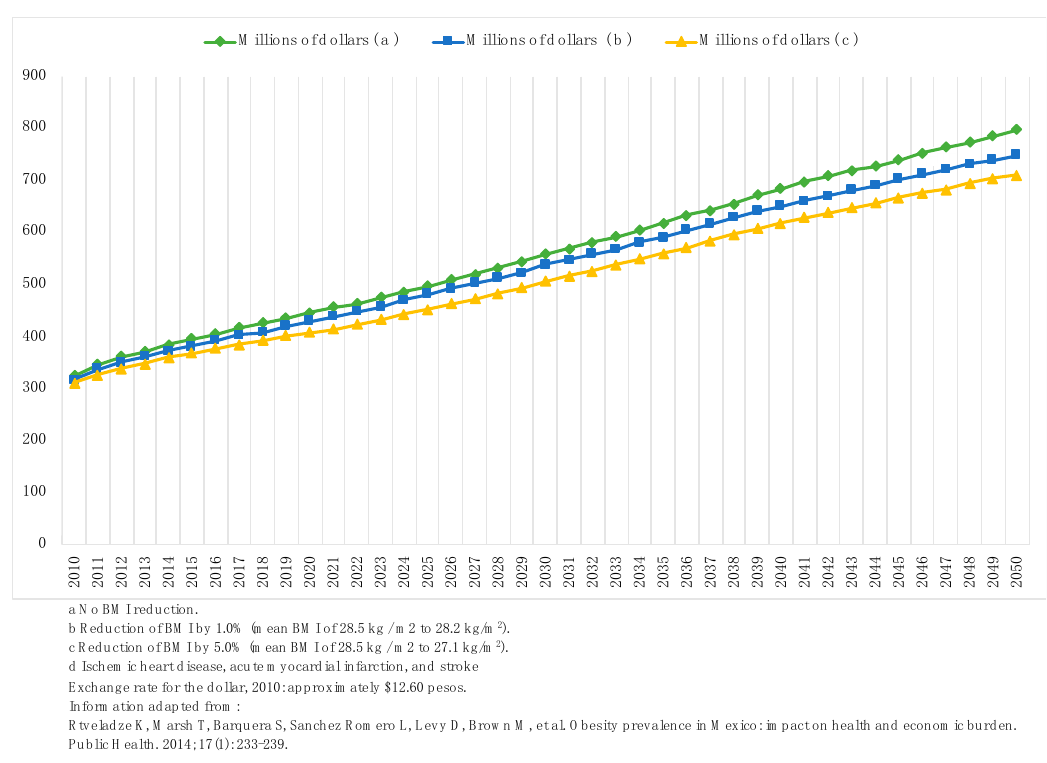
0100200300400500600700800900 020 1 120 1 220 1 320 1 420 1 520 1 620 1 720 1 820 1 920 2 020 2 120 2 220 2 320 2 420 2 520 2 620 2 720 2 820 2 920 3 020 3 120 3 220 3 320 3 420 3 520 3 620 3 720 3 820 3 920 4 020 4 120 4 220 4 320 4 420 4 520 4 620 4 720 4 820 4 920 5 0 20 1 a N o BM I reduction. b Reduction of BM I by 1.0% (m ean BM I of 28.5 kg / m 2 to 28.2 kg/m 2 ). c Reduction of BM I by 5.0% (m ean BM I of 28.5 kg / m 2 to 27.1 kg/m 2 ). d Ischem ic heart disease, acute m yocardial infarction, and stroke Exchange rate for the dollar, 2010: approxim ately $12.60 pesos. Inform ation adapted from : Rtveladze K, M arsh T, Barquera S, Sanchez Rom ero L, Levy D , Brow n M , et al. O besity prevalence in M exico: im pact on health and econom ic burden. Public H ealth. 2014; 17(1): 233-239. Figure 2. Projected costs of ischemic heart disease, acute myocardial infarction, and stroke. Mexico 2010–2050.